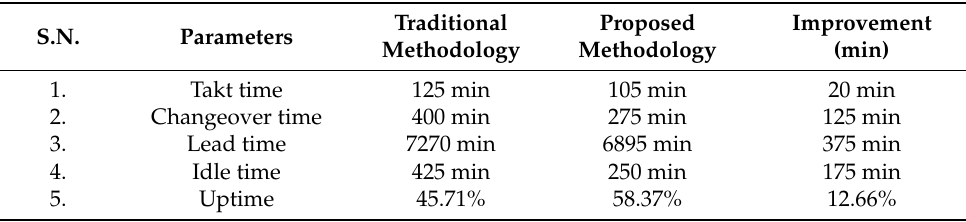
Table 6. Improvements in the various parameters of the shop